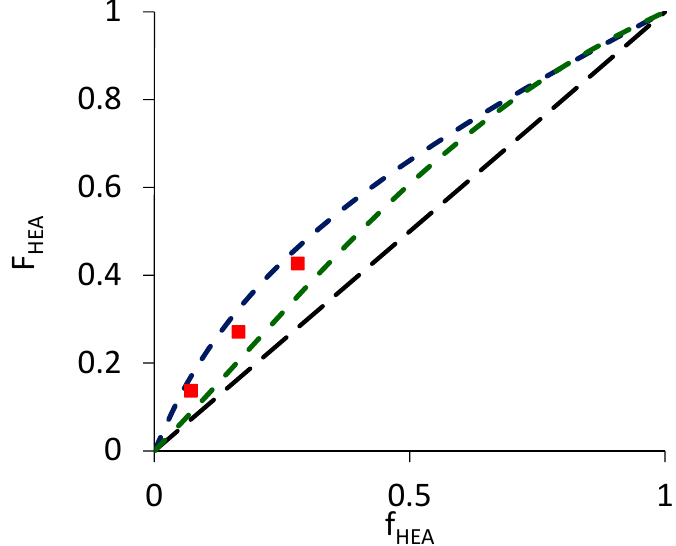
Figure 2. Comparison of HEA copolymer mole fraction ( F HEA ) as a function of HEA comonomer mole fraction ( f HEA ) under semi-batch operating conditions for BA/HEA copolymerizations in BPi ( ■ ) to terminal model fits to data obtained by low conversion kinetic studies in bulk ( --- ) and methyl isobutyl ketone ( --- ) [14].